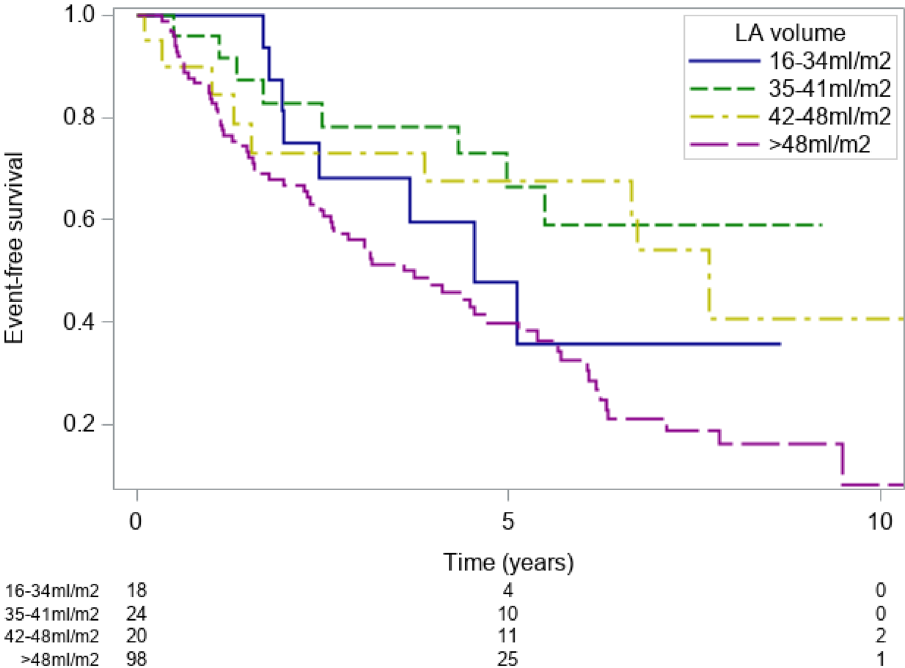
Figure 5. Kaplan–Meier event-free survival estimates patients included after beginning of 2005 with an indexed LA volume of 16-34 ml/m 2 (blue line), an indexed LA volume of 35-41 ml/m 2 (green line), an indexed LA volume of 42-48 ml/m 2 (yellow line) and an indexed LA volume of > 48 ml/m 2 (purple line).